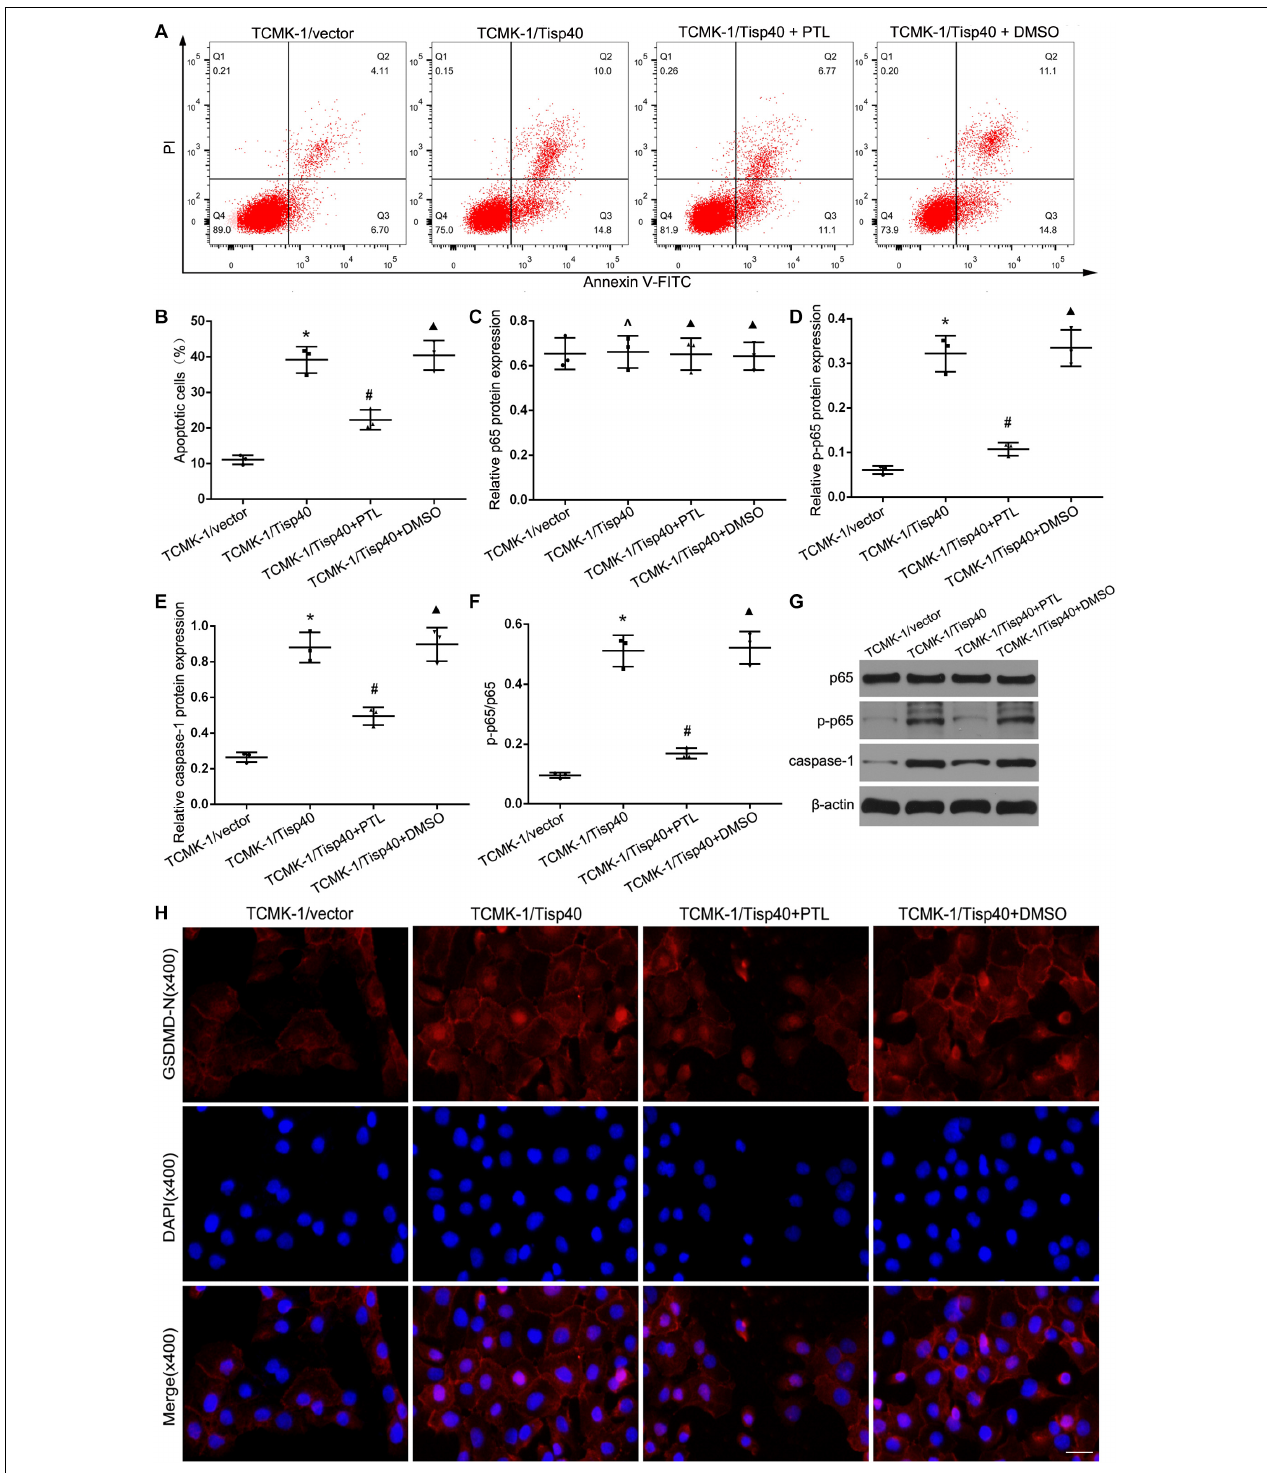
FIGURE 7 | Tisp40 regulated GSDMD-mediated pyroptosis via NF- κ B pathway in OGD/R stimulated TCMK-1 cell. (A) Flow cytometry assays were performed to show the cell pyroptosis. (B) Statistical analysis was used to show pyroptosis cells. (C,D,E,G) The expression of p65,p-p65 and caspase1 were analyzed by Western blot. (F) The ratio of p-p65 to p65 reflect phosphorylation level of p65. (H) Representative photomicrographs of GSDMD-N expression in TCMK-1 cells by Immunofluorescence, 400 × , scale bar = 20 µ m. Data are expressed as the mean ± SD. n = 5 per group. * P < 0.05, ∧ P > 0.05 vs. TCMK-1/vector group. # P < 0.05, (cid:78) P > 0.05 vs. TCMK-1/Tisp40 group, one-way ANOVA.